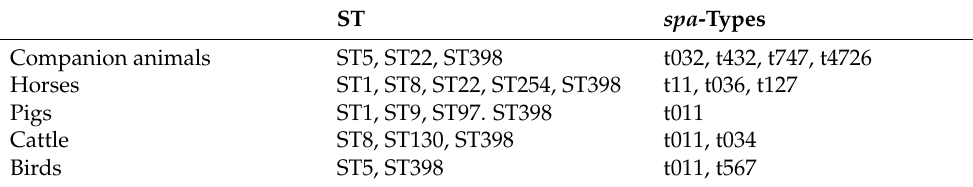
Table 1. Major MRSA strains associated with companion animals and farm